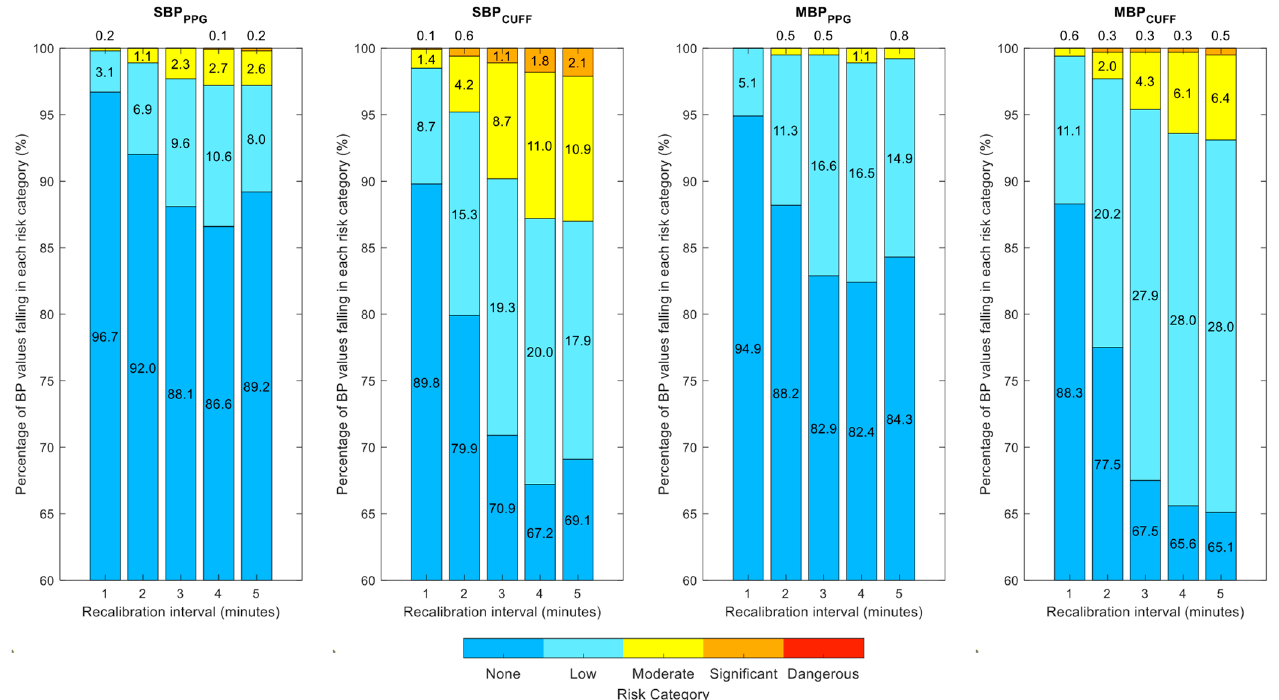
Figure 4. Percentage of points falling in each risk category as a function of the recalibration interval.